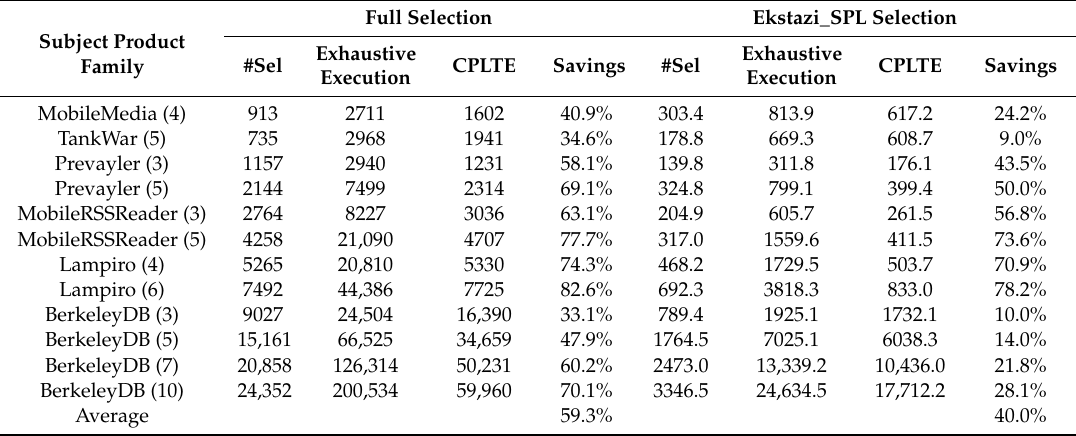
Table 4. Number of test executions and savings of Checksum-based Product Line Test Execution